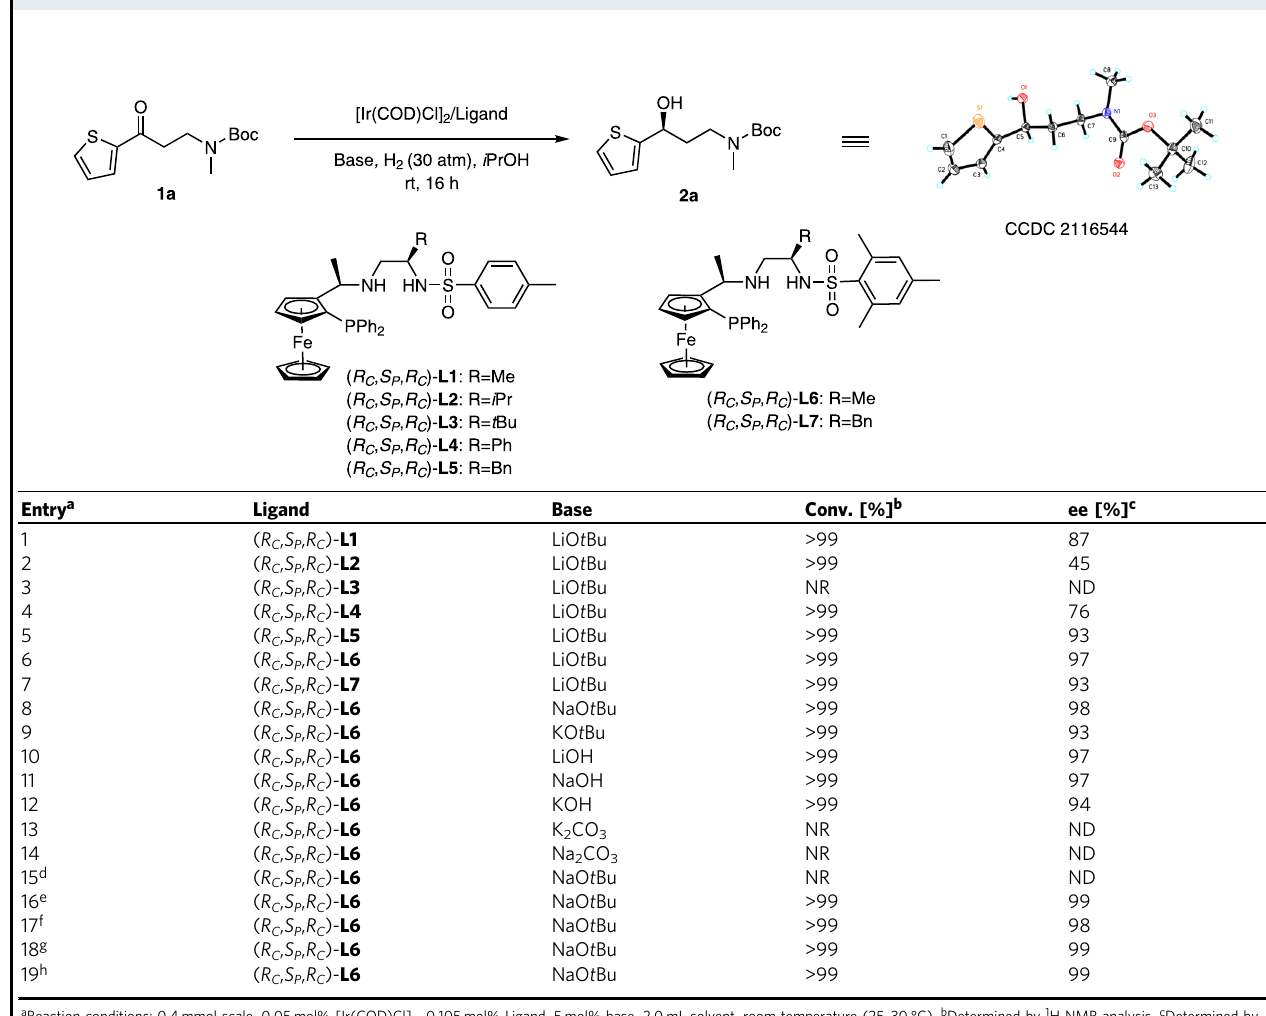
Table 1 Optimization of reaction conditions for asymmetric hydrogenation of